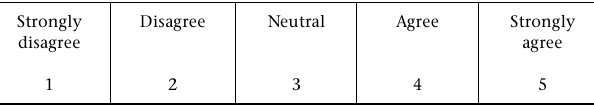
Figure 4: Intensity scale (Adapted from Schepers,